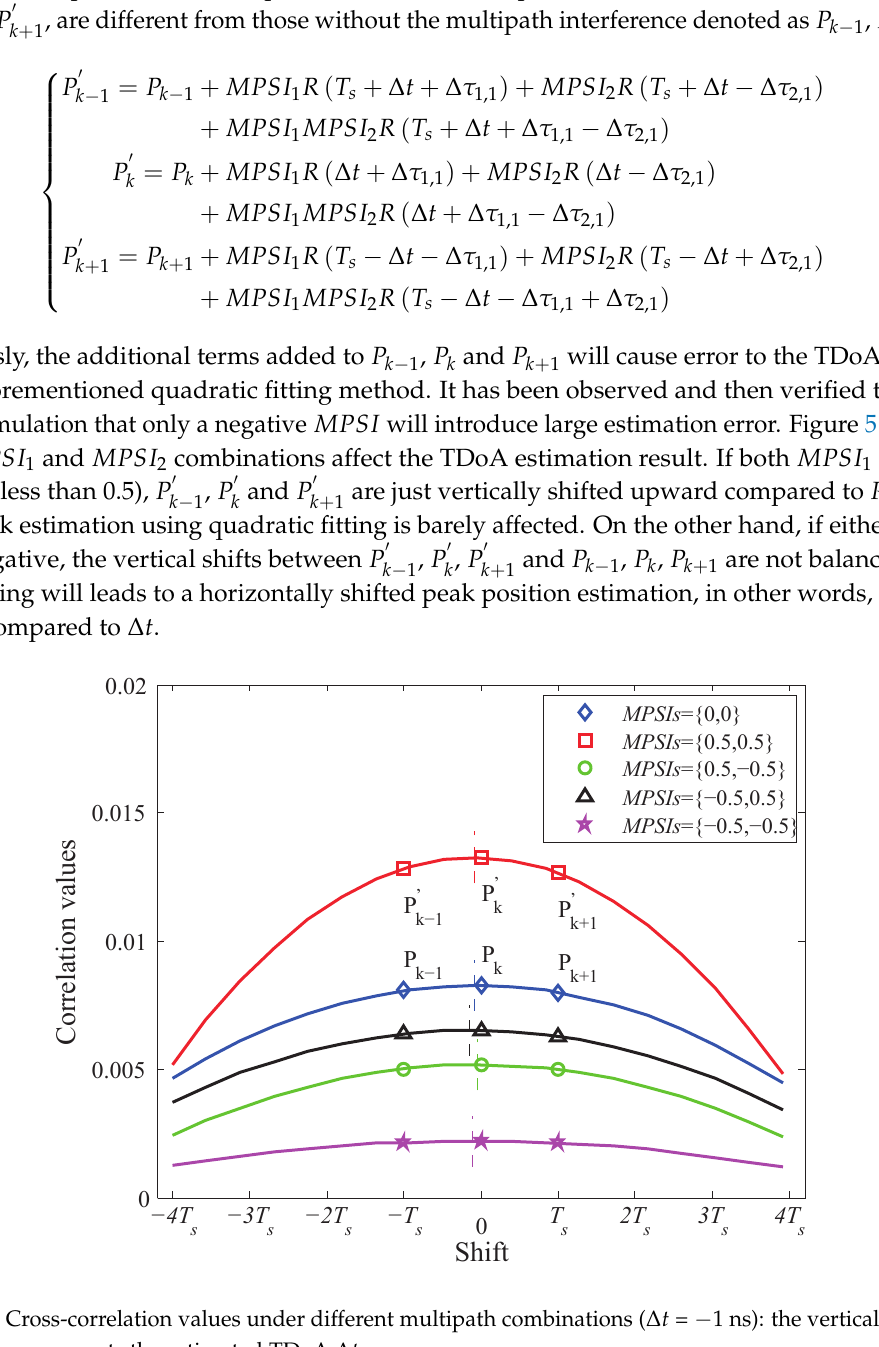
Figure 5. Cross-correlation values under different multipath combinations ( ∆ t = − 1 ns): the vertical line on each curve represents the estimated TDoA ∆ t est